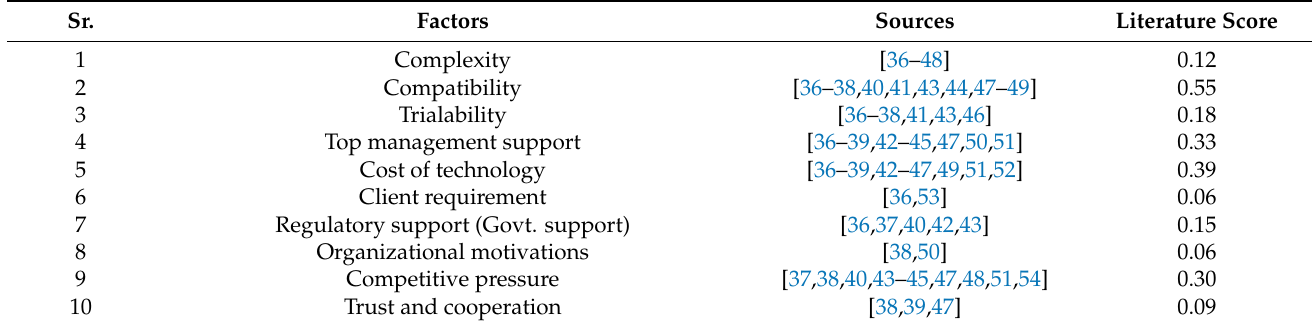
Table 2. Factors affecting the adoption of collaboration